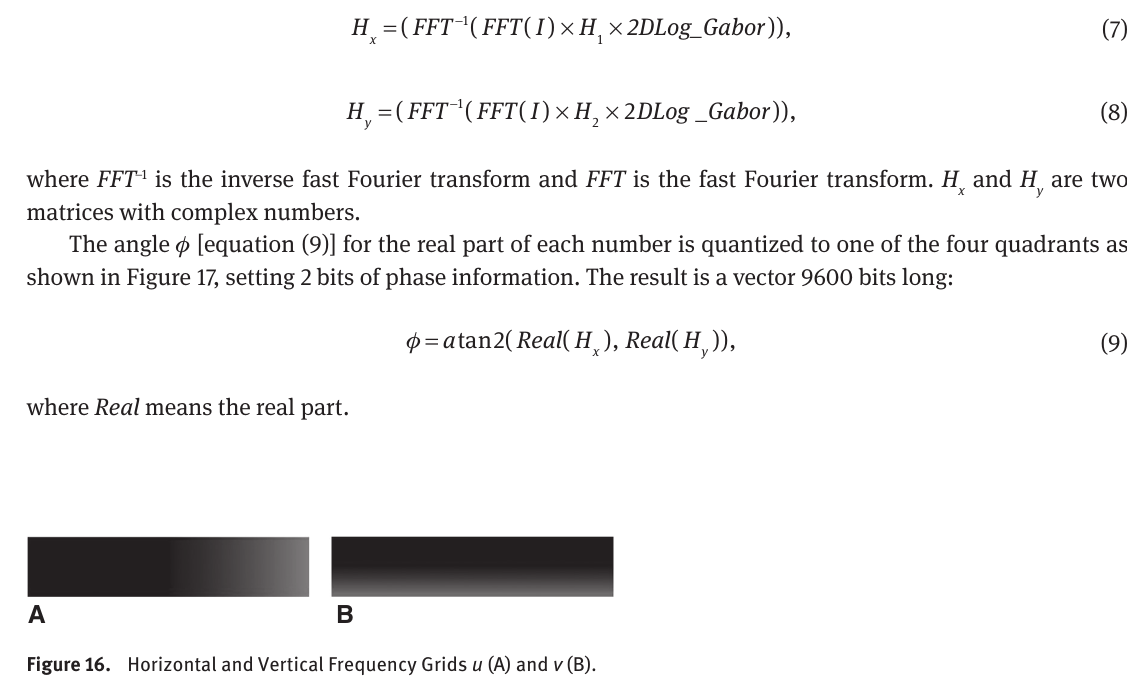
Figure 16. Horizontal and Vertical Frequency Grids u (A) and v